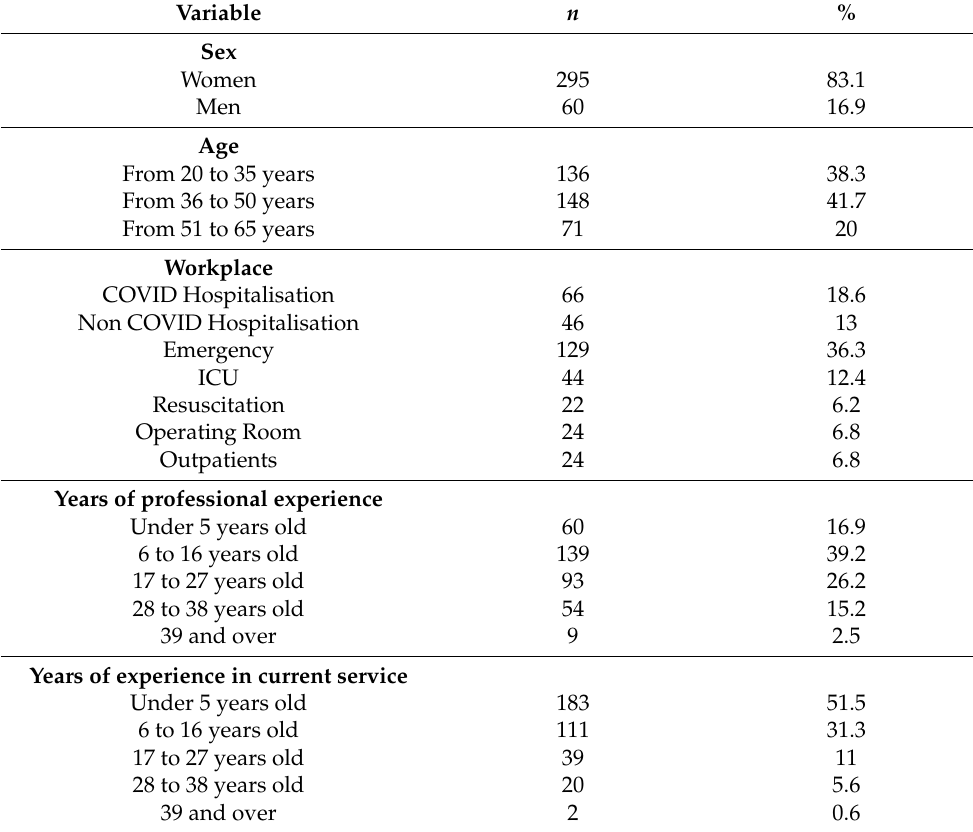
Table 1. Socio-demographic and employment characteristics of participants (N = 355).